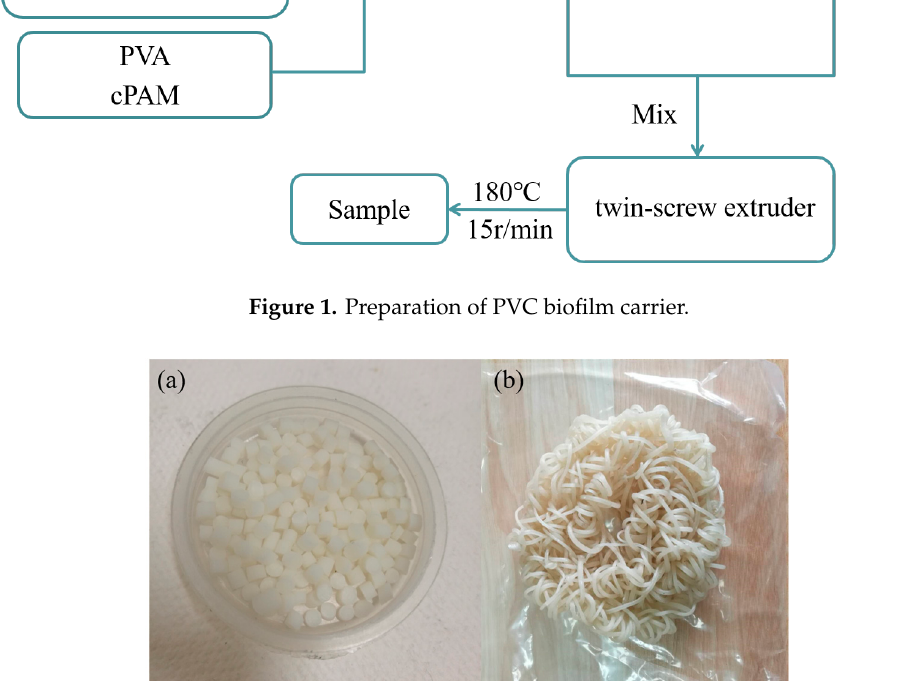
Figure 2. The photo of sample ( a ) sample particles, ( b ) sample.